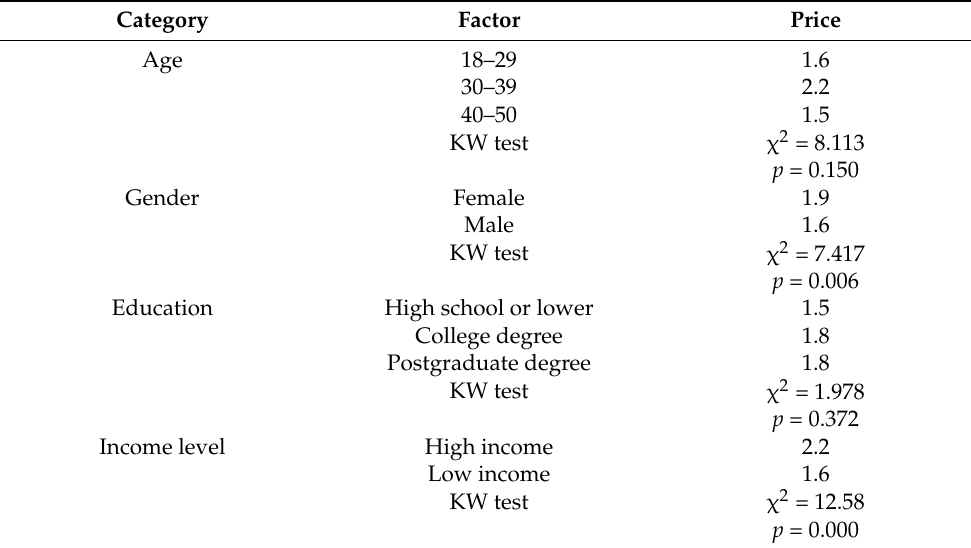
Table 4. The Kruskal–Wallis test results for the demographic factors on psychological price for stopping purchasing plastic carrier